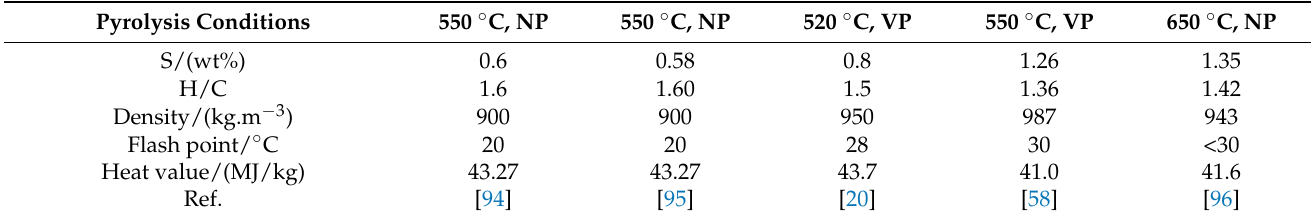
Table 3. Physical properties of pyrolysis oil under different